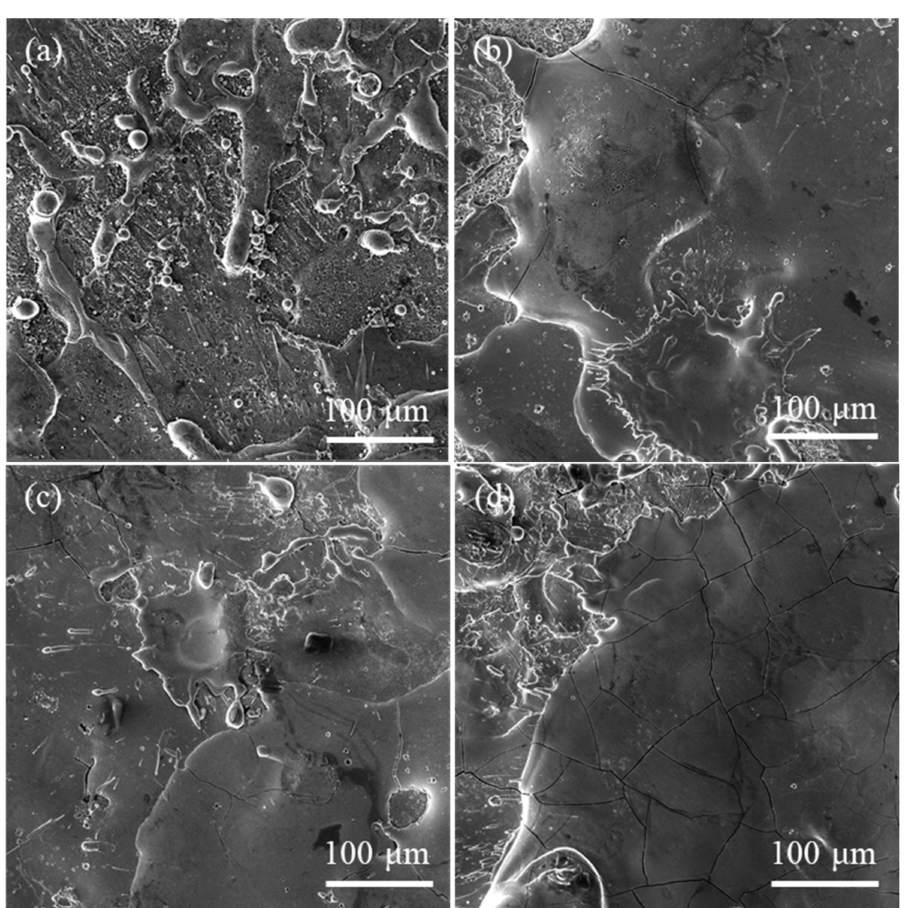
Figure 9. Frontal images of coating: ( a ) 2 min/cm 2 , ( b ) 3 min/cm 2 , ( c ) 4 min/cm 2 , and ( d ) 5 min/cm 2 .